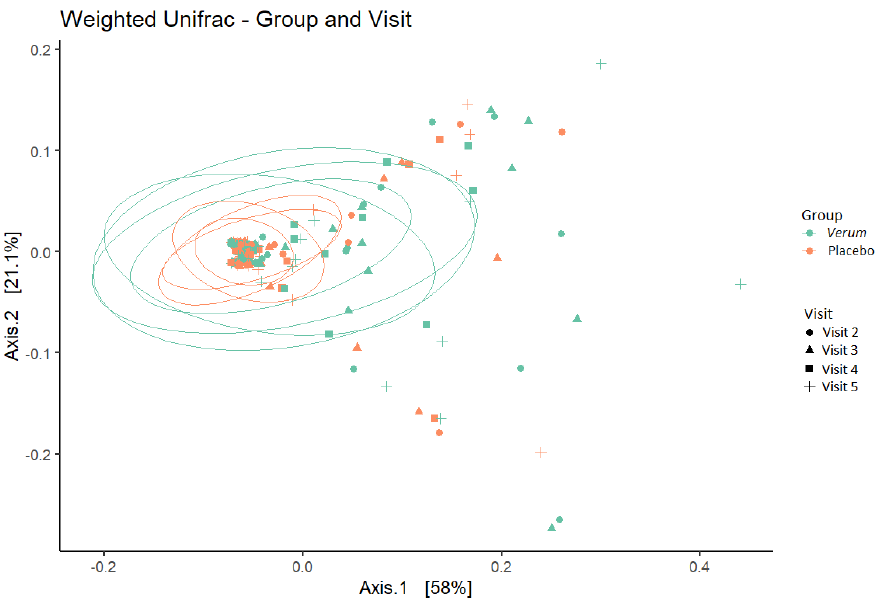
Figure 4. β−diversity (weighted UniFrac metric) depicting sample clustering of the vaginal microbiota samples from study participants by intervention group and visit in a principal coordinate analysis (PCoA) plot. Ellipses represent 95% confidence interval. Visit 2, baseline visit; Visit 3, after one week of intervention; Visit 4, after two weeks of intervention; Visit 5, after a one-week follow-up. Abundances of families, genera, and ASVs were comparable between verum and placebo and remained stable over time. One participant from the placebo group, with L.